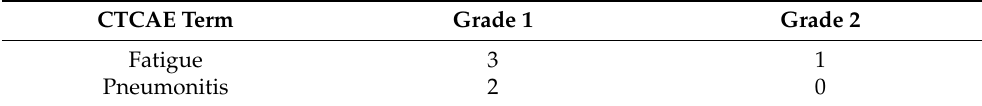
Table 4. Acute adverse